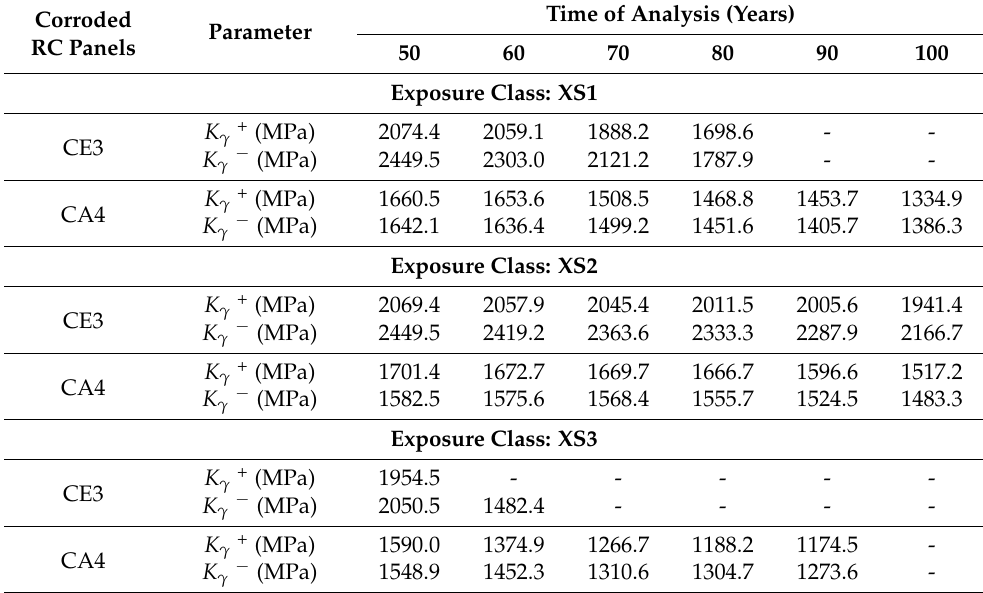
Table A2. Variation over time of the pre-yield shear stiffness (positive and negative values) in function of different exposure classes - for the two investigated